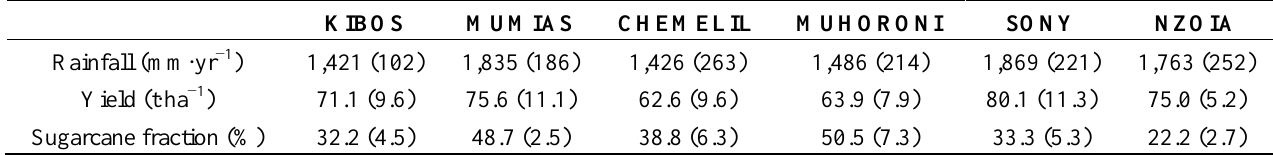
Table 1. Summary of the agronomic and climate data used in the study: mean and standard deviation (in parenthesis) calculated over the 9-year period